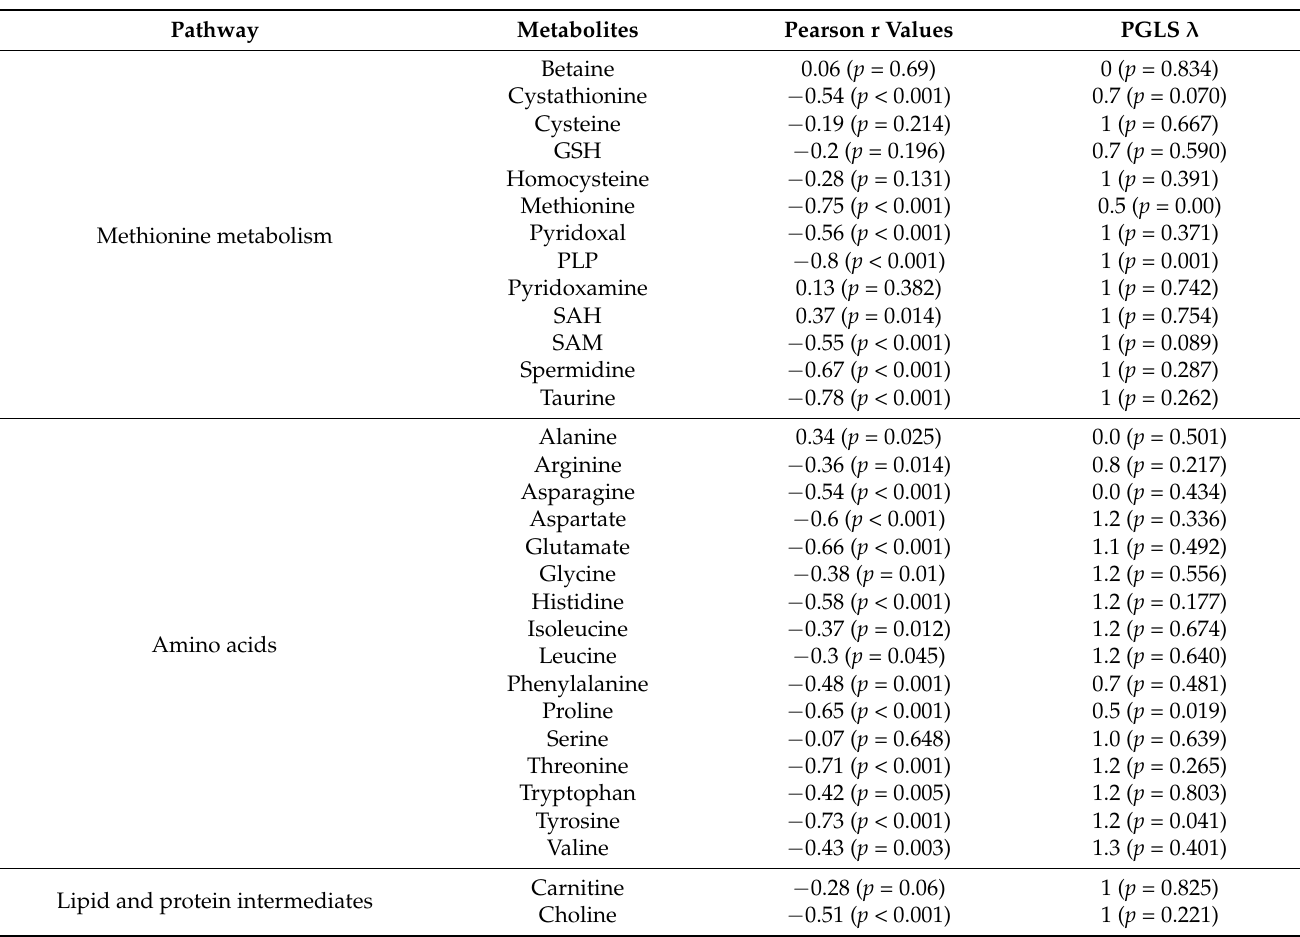
Table A2. Heart metabolite correlation with animal longevity. Pearson r values are reported. Pagel’s λ value measures phylogenetic signal for each individual metabolite. Phylogenetic generalized least squares (PGLS) regression between heart metabolites and longevity corrects for phylogenetic relationships. Minimum significance level was set at p < 0.05. All metabolites were log-transformed to accomplish the assumptions of normality. Phylogenetic generalized least squares (PGLS); Glutathione (GSH); pyridoxal 5 (cid:48) phosphate (PLP); S-adenosylmethionine (SAM); S-adenosylhomocysteine